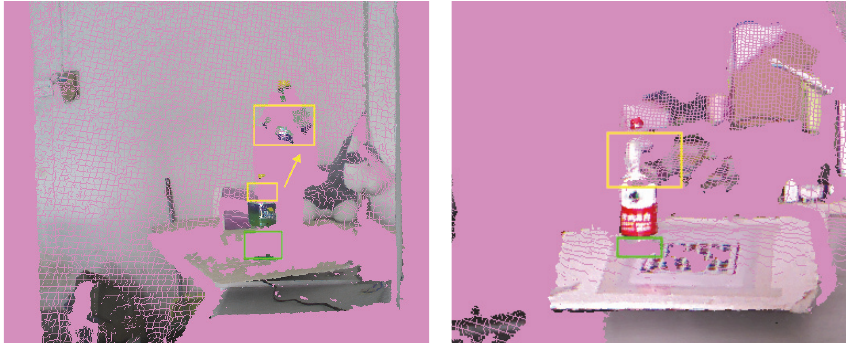
Figure 3: 3D point clouds show two kinds of depth appearance of transparent object; Green rectangles label the zero-depth noise which is consistent across frames. Yellow rectangles label the wrong depth noise mingled with zero depth which keeps on changing across frames; the wrong depth may be drifted to a farther location than the real